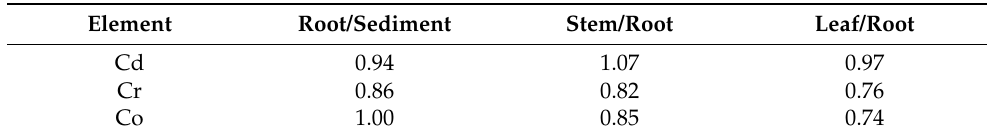
Table 3. Transfer factor of PTEs from roots to other organs Glyceria maxima of from Pisa River (mean) and its tributaries.